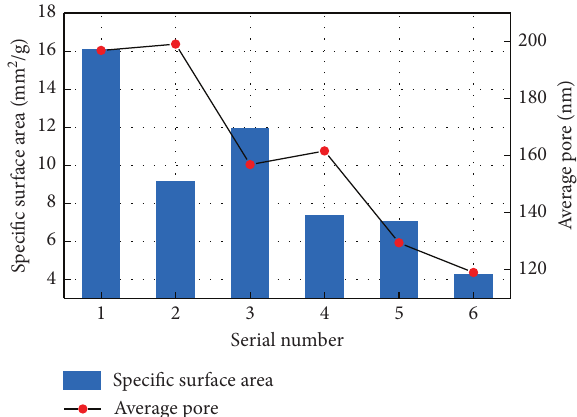
Figure 7: Specific surface area and mean pore diameter of coal samples with different metamorphic